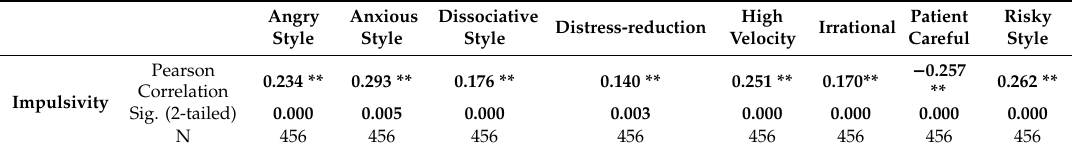
Table 2. Correlations between the driving styles and